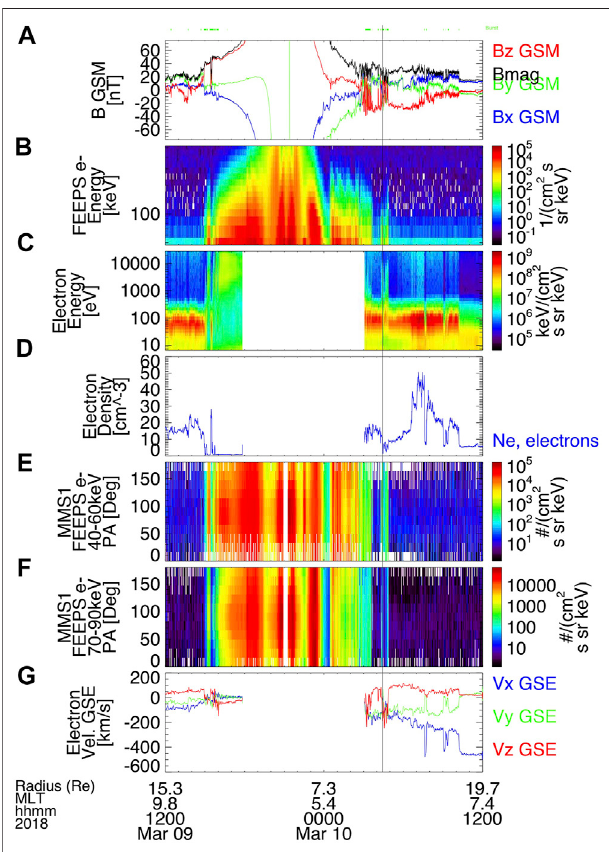
FIGURE 1 | An example of a boundary crossing event containing whistler waves at 04:26 on 10 March 2018. (A) Magnetic fi eld in DMPA coordinates, (B) FEEPS electron energies, (C) Lower-energy electron energies, (D) Lower-energyionenergies, (E) Fluxofbackgroundthermal electrons looking at 0 ° (black) and 180 ° (pink), (F) Parallel (blue) and perpendicular (green) electron temperatures, (G) Parallel (red) and perpendicular (black) ion temperatures, (H) Magnetic fi eld power spectral density, (I) Electric fi eldpowerspectraldensity.Forthelasttwopanels,thehalf electron cyclotron frequency is plotted. The vertical line shows the end of the boundary layer crossing with FEEPS enhancements while the arrow points to the whistler waves.